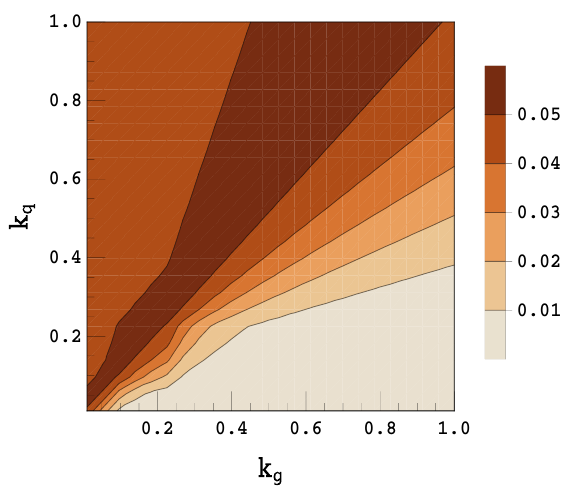
Figure 2 . The contour plot of couplings k q and k g for signal at NNLO with a fixed value of the spin-2 mass M G = 1 TeV. The plot shows the cross-section (in pb ) at the resonance Q = M G